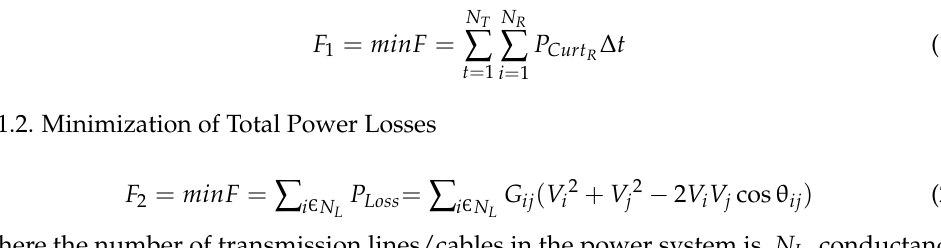
6 Figure 4. Type 3 wind turbine and farm. 4. Egyptian Power Grid Optimization